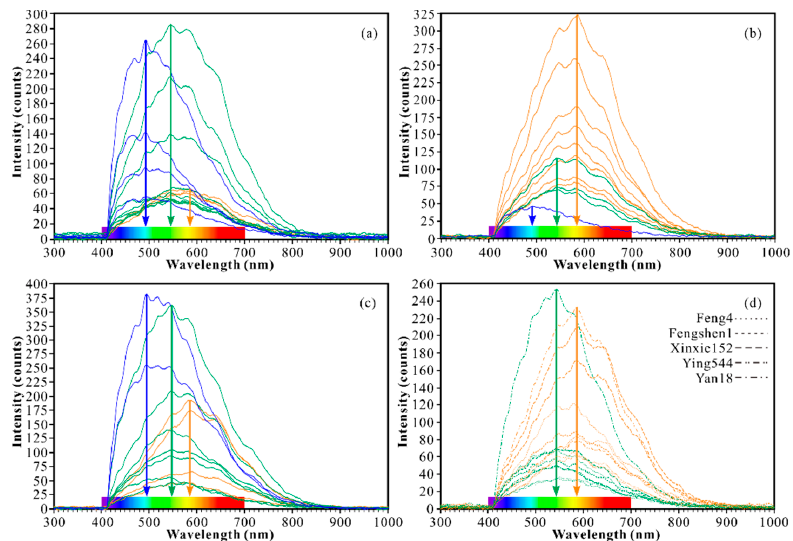
Figure 4. Fluorescence spectra of typical petroleum inclusions. ( a ) data from well Feng14; ( b ) data from well Feng112; ( c ) data from well Yan182; ( d ) data from wells of Feng4, Fengshen1, Xinxie152, Ying544 and Yan18.